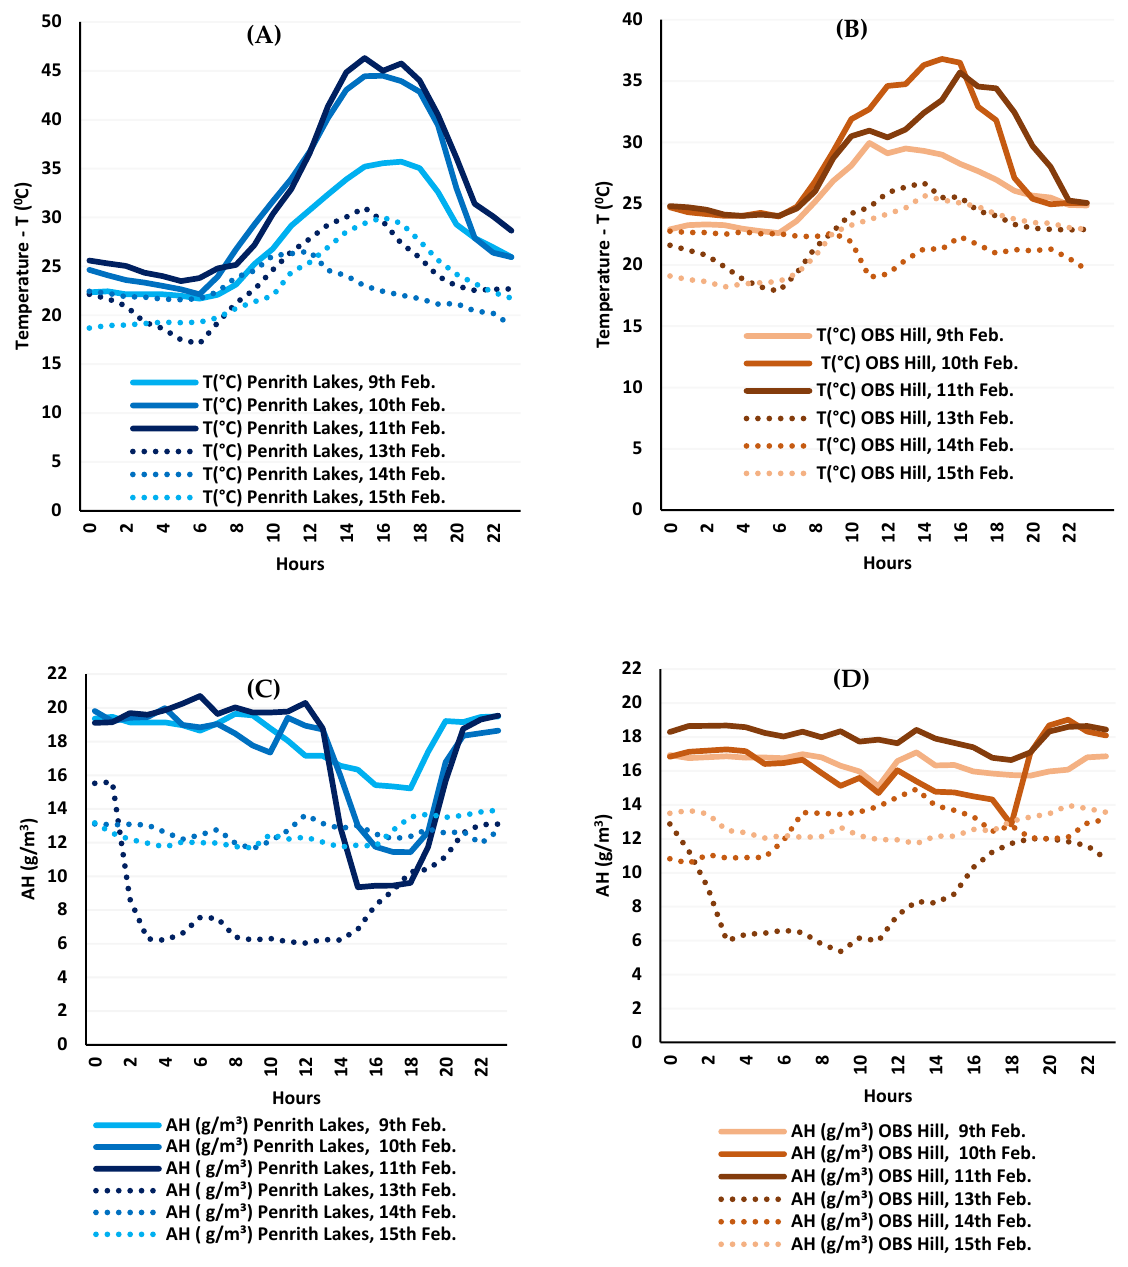
Figure 7. Temperature profile ( ◦ C) and AH (g / m 3 ) at Penrith Lakes and OBS Hill during HW (9–11 February 2017) & NHW (13–15 February 2017) Periods. ( A ) Temperature profiles at Penrith Lakes during HW and NHW periods, ( B ) Temperature profiles at OBS Hill during HW and NHW periods, ( C ) AH profiles at Penrith Lakes during HW and NHW periods, ( D ) AH profiles at OBS Hill during HW and NHW